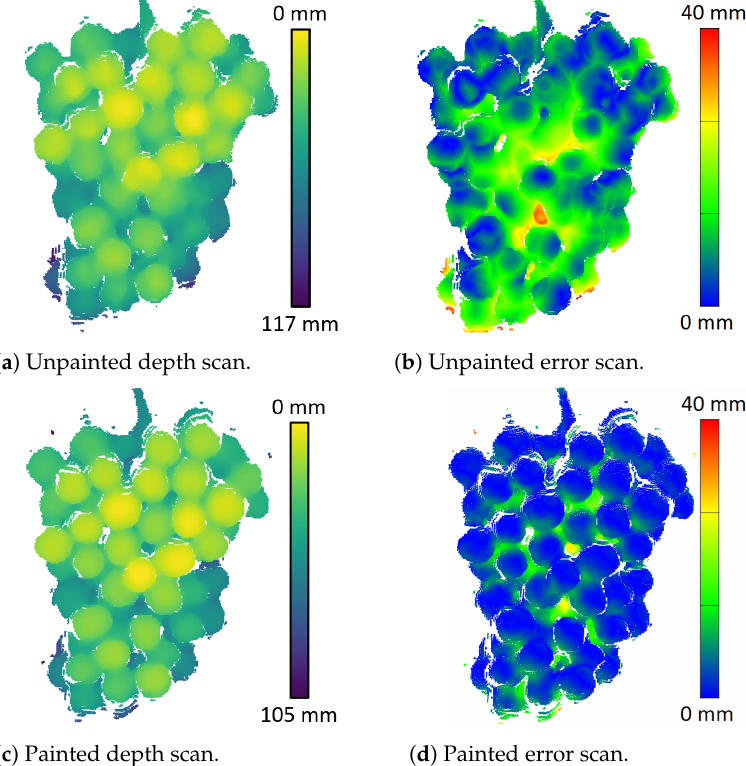
Figure 8. Depth and error scans for the Intel L515 before and after spray painting the grape bunch with white paint.